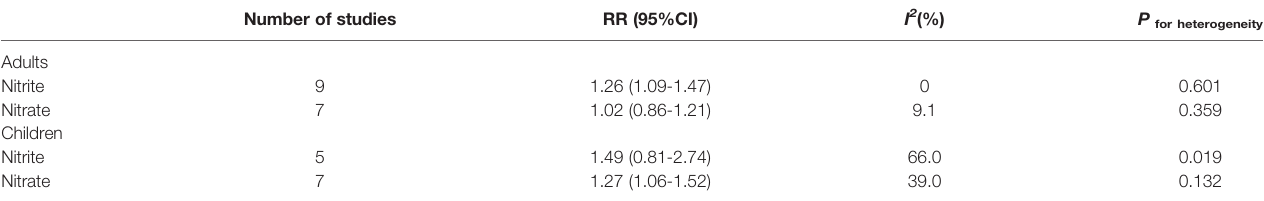
TABLE 2 | A meta-analysis of the association between nitrite/nitrate and glioma. Number of